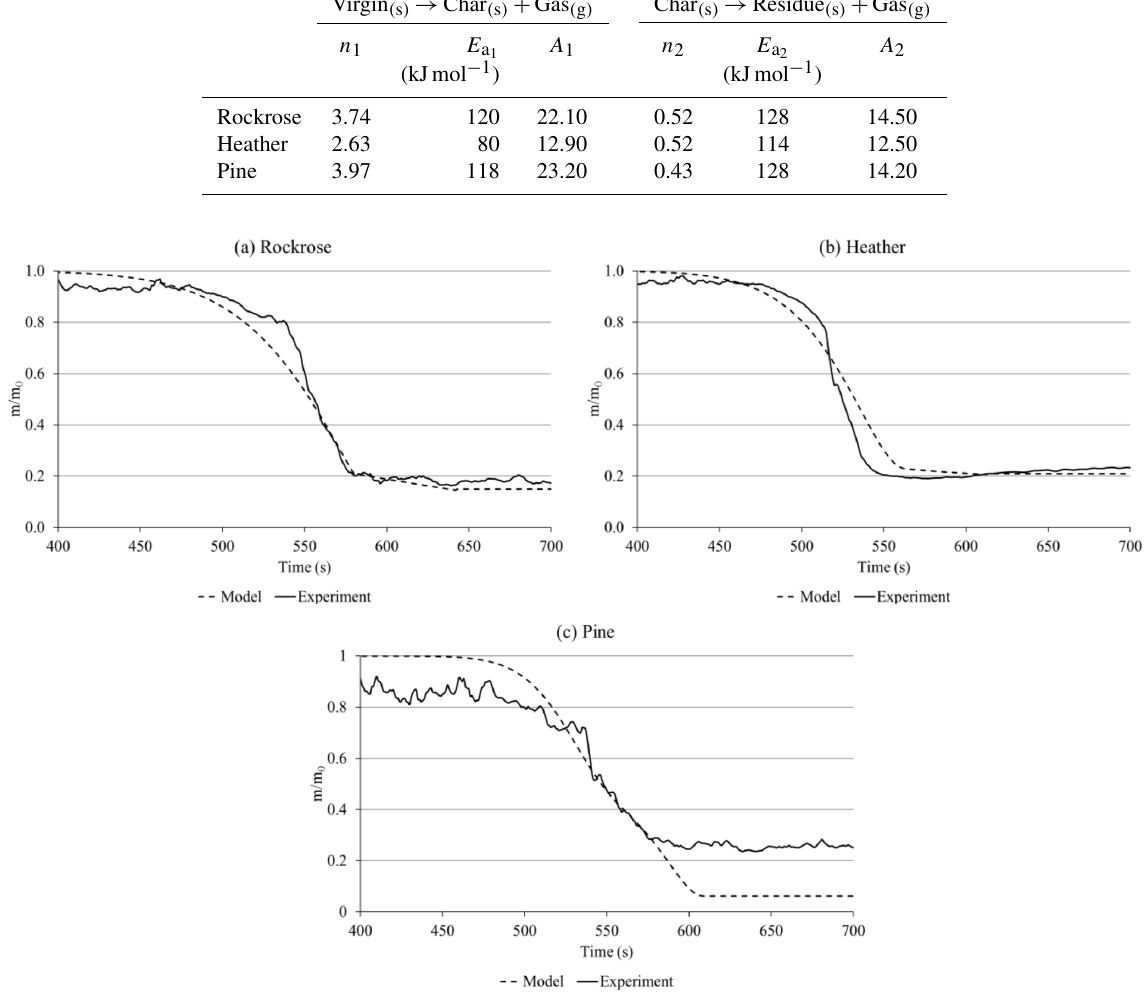
Figure 10. Experimental (solid line) and modelled (dashed line) mass loss for (a) rockrose, (b) heather and (c)